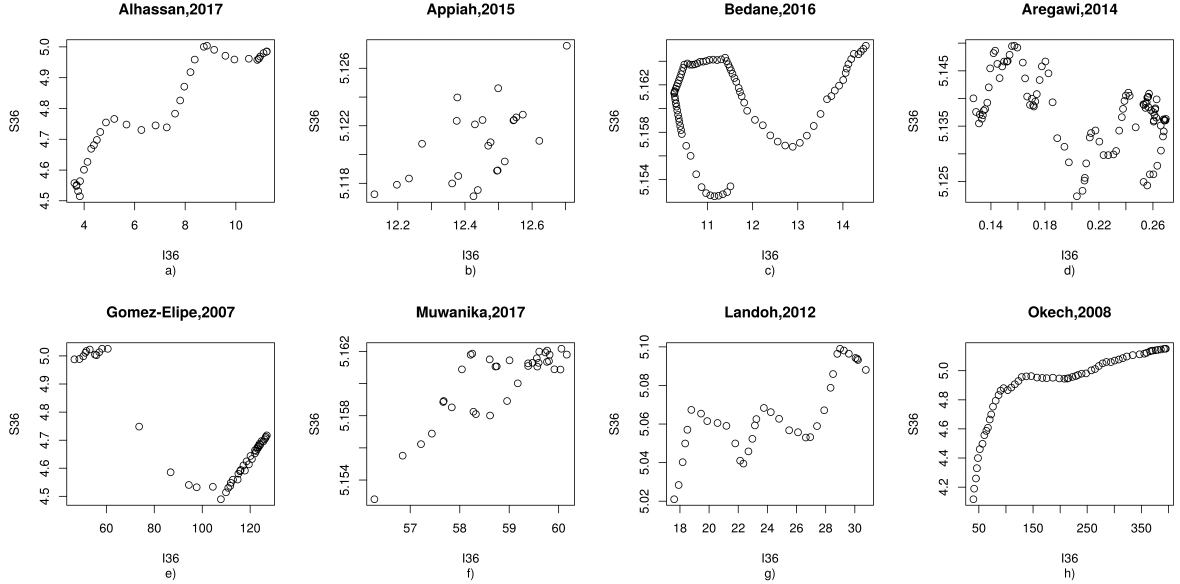
Figure A1. Illustration of how 36-month moving average malaria incidence in the x -axis, symbol- ized as I 36 relates to 36-months Hurst exponent H 36 in th y -axis in malaria empirical time series: ( a ) Alhassan et al. (Kasena Nankana municipality in Ghana, 2017) [21]. ( b ) Appiah et al. (Ejisu- Juaben municipality in Ghana, 2015) [16], ( c ) Bedane et al. (Kucha district in Ethiopia, 2016) [23], ( d ) Aregawi et al. (Ethiopia, 2014) [22], ( e ) Gomez-Elipe et al. (Karuzi in Burundi, 2007) [24], ( f ) Muwanika et al. (Uganda, 2017) [26], ( g )Landoh et al. (Est Mono district in Togo, 2012) [25], ( h ) Okech et al. (Kenya, 2008) [27].